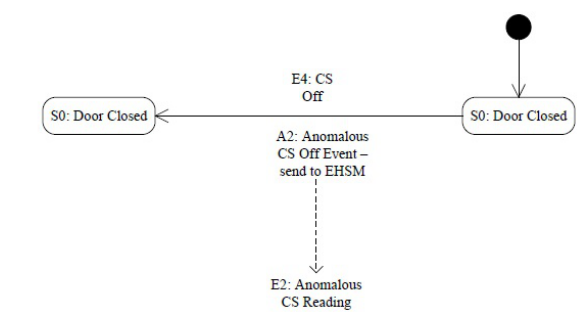
Figure 5: An example of the logical flow between the NASM and